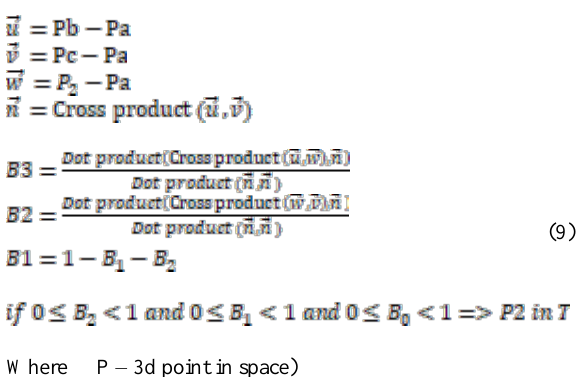
Based on the triangle T represented in the Figure 7, defined by the points (Pa, Pb, Pc), the algorithm starts by building vectors between two triangle vertices and both a triangle vertex and described in (9) are then calculated in way to compute the